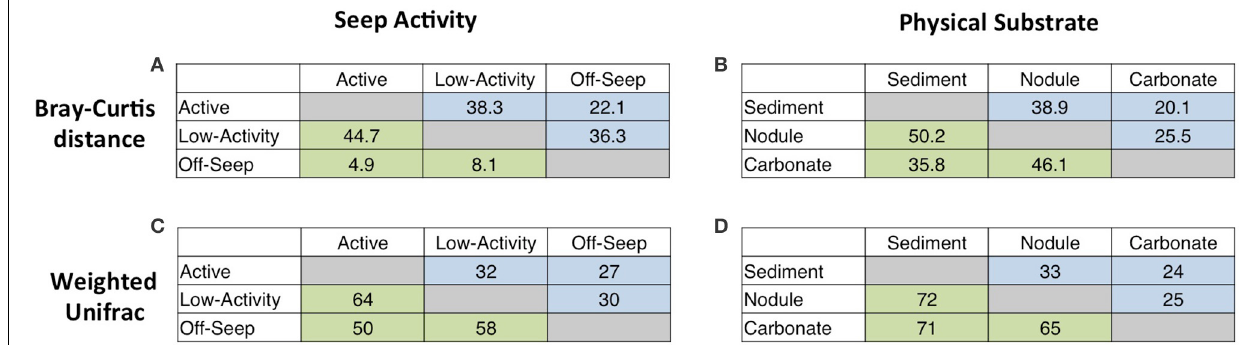
Green-shaded fields contain data from archaeal sequences; blue-shaded fields contain Bacteria-specific data. Weighted UniFrac values were subtracted from 1 and multiplied by 100 to provide a more intuitive statistic; in all cases, higher numbers indicate more similar communities.